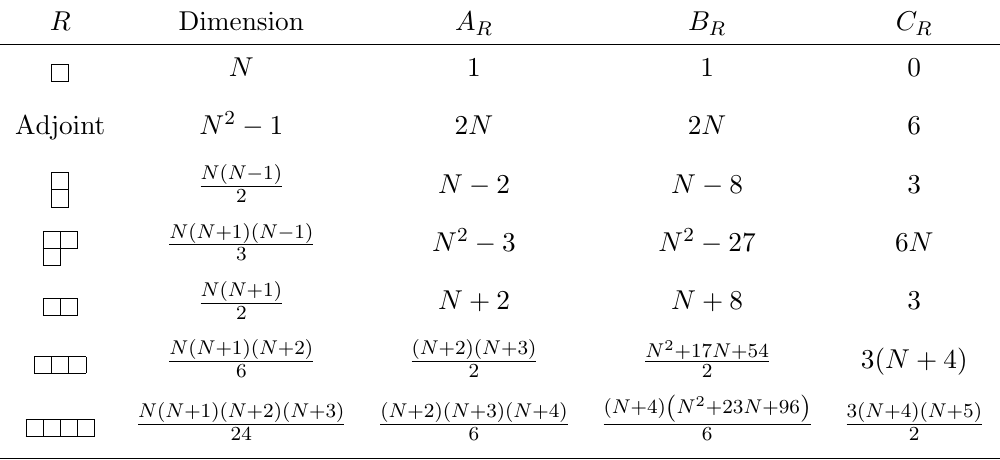
Table 1 . Values of the group theory coe(cid:14)cients A R , B R , and C R , and the dimensions, associated with a variety of representations R of SU( N ), for N (cid:21) 4. For SU(2) and SU(3), no quartic Casimir exists, so B R = 0. In this case, the value of A R is as given, and the value of C R is obtained by taking C R + B R = 2 using the values given